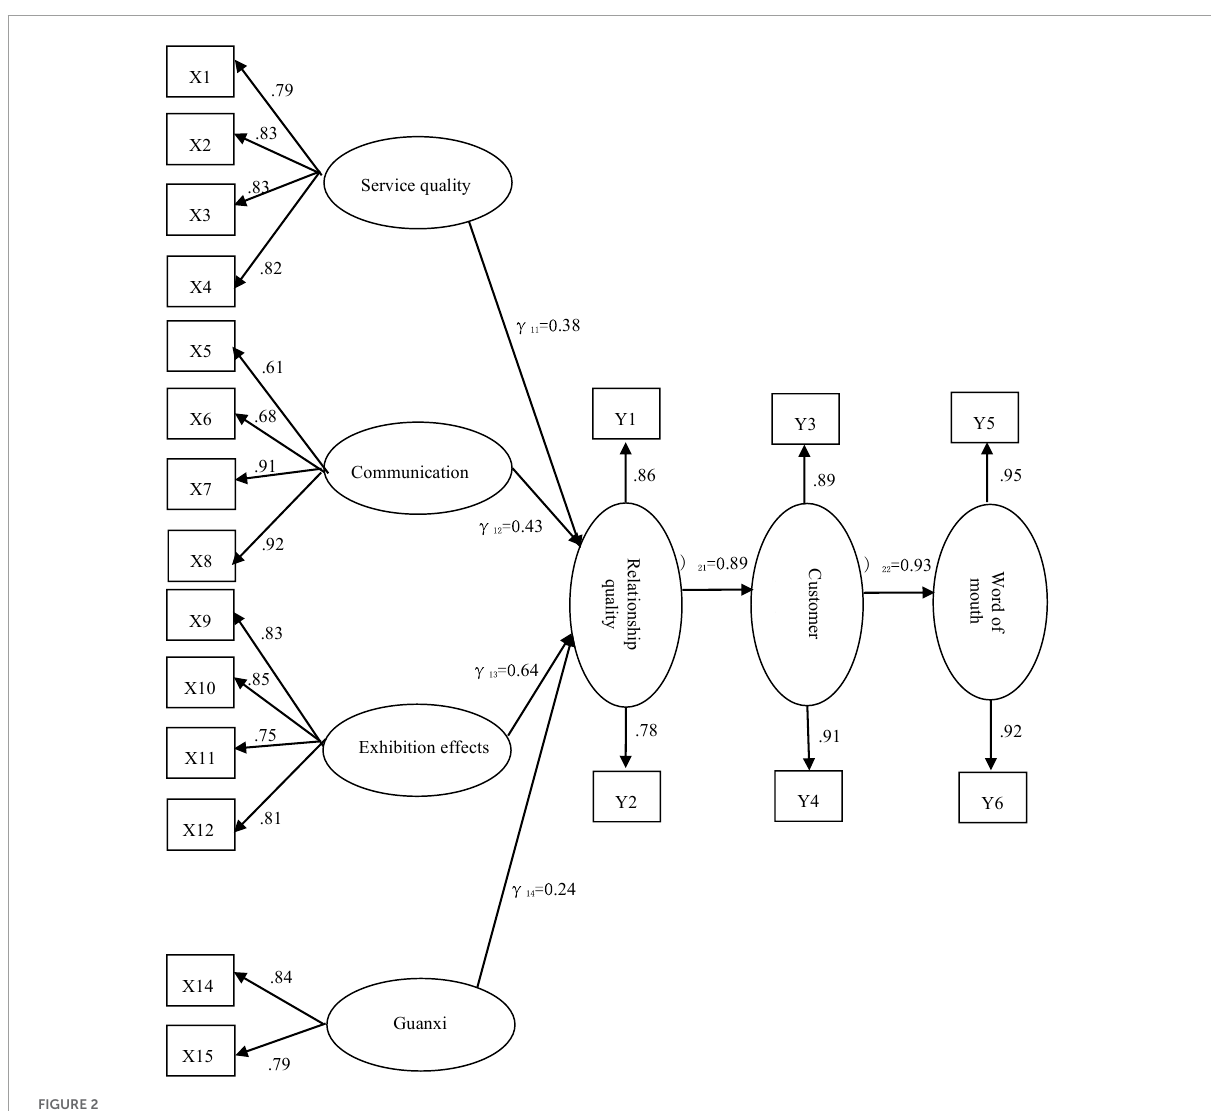
FIGURE2 Correction diagram of the causal model of the relationship between exhibitors and exhibition